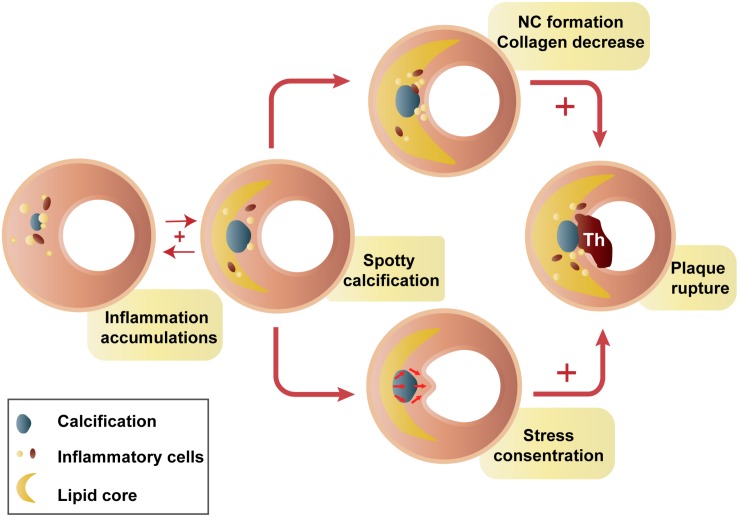
Hypothesis of spotty calcification in plaque rupture. Two main ways that spotty calcifications lead to plaque rupture: inflammatory cytokines from macrophages activate osteogenic differentiation, contributing to early stages of calcification. Then, a positive feedback loop between inflammation and calcification produces spotty calcification, stimulating accelerated plaque progression, including greater inflammatory burden, a larger necrotic core, and less collagen (Aikawa et al., 2007; Kataoka et al., 2012; Pu et al., 2014, 2016a; Hsu et al., 2016). In contrast, calcification neighboring the lipid pool, especially that near the fibrous cap, may intensify failure stress and cause plaque rupture (Bluestein et al., 2008; Hoshino et al., 2009). NC, necrotic core; Th, thrombus.